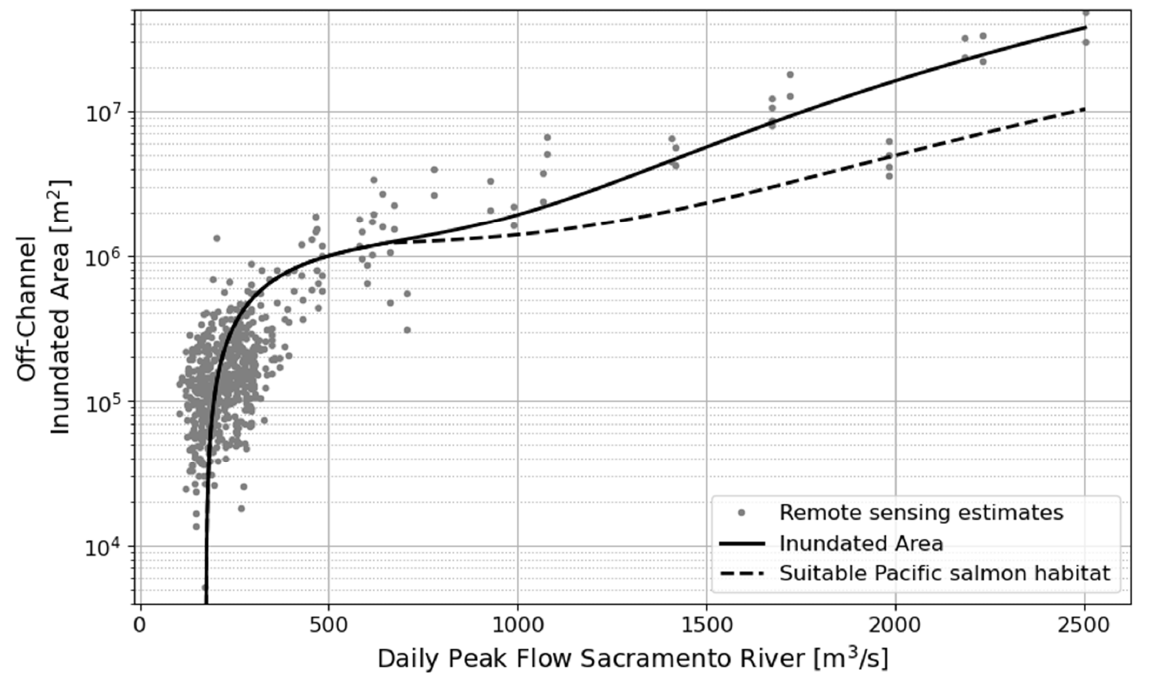
Figure 6. Fitted flow-habitat curve using Chebyshev polynomials and approximated suitable habitat. Table 4. Average proportion (%) of total off-channel inundation extent under different mainstem flows along five Sacramento River sections (defined in Figure